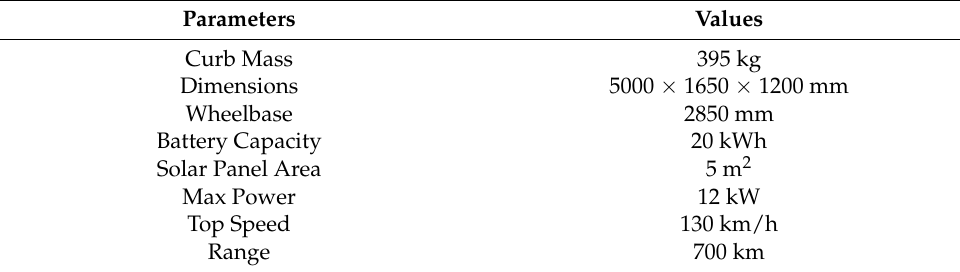
Table 1. Specifications of “Sun Shuttle